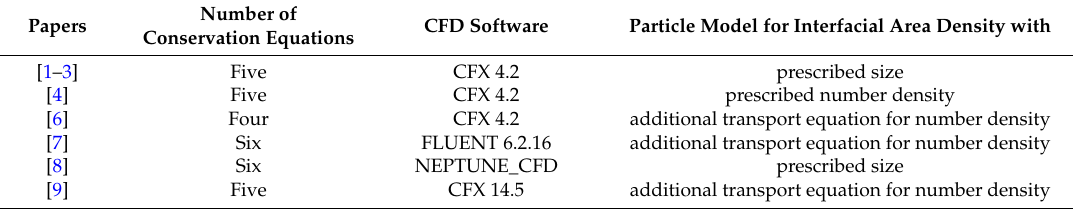
Table 1. Model setup available for CFD simulation of flashing